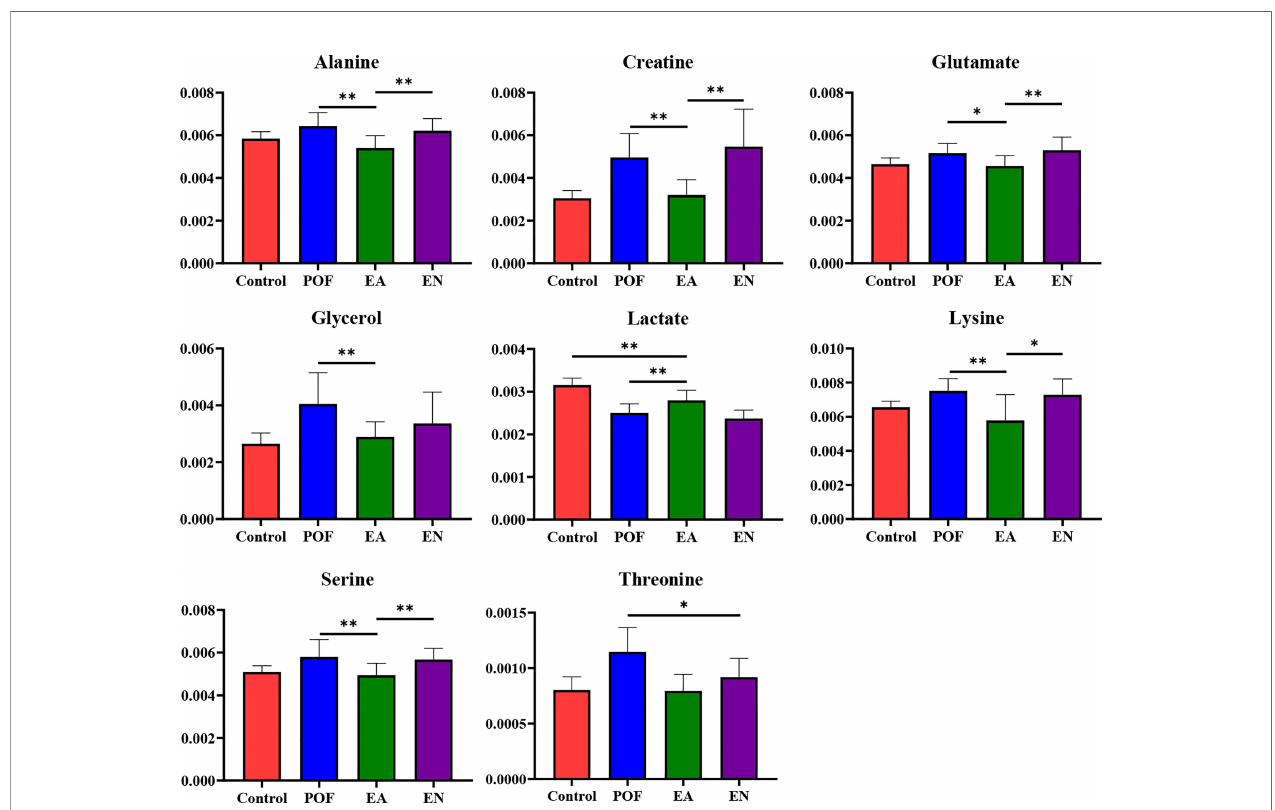
FIGURE 9 | The relative concentrations of characteristic metabolites in the kidney (* means P < 0.05; ** means P < 0.01).